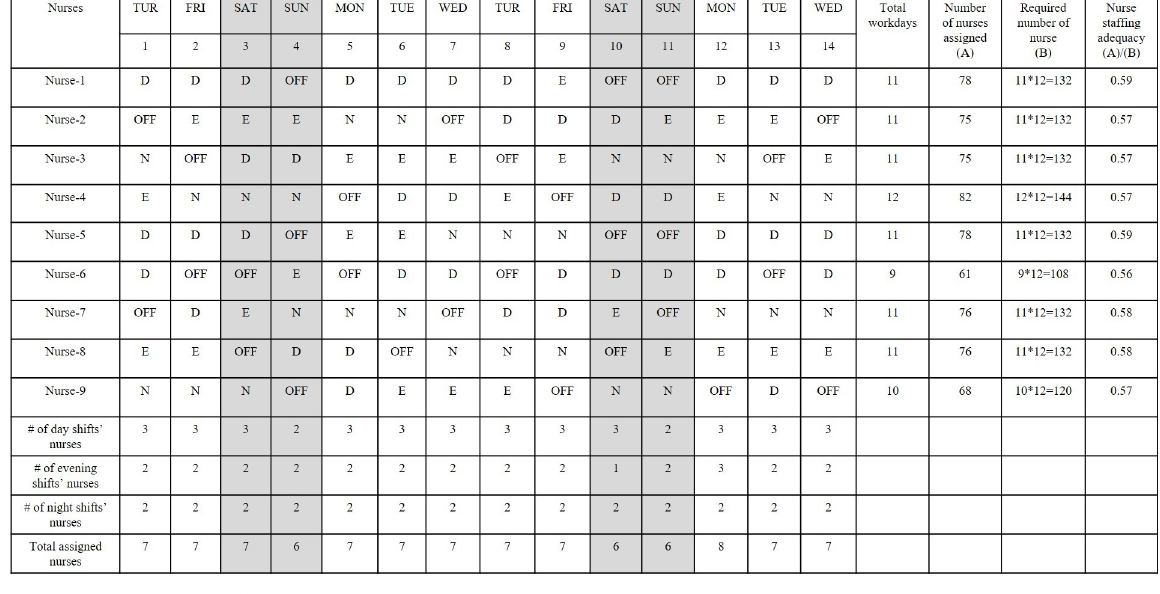
Fig 1. Example of nurse staffing